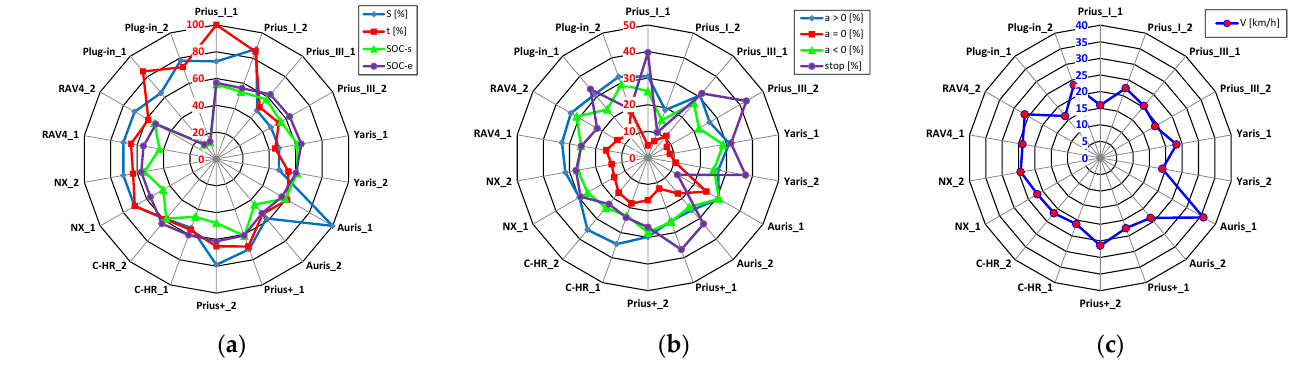
Figure 5. Analysis of vehicle traffic conditions: ( a ) percentage of time and distance traveled, as well as initial and final battery state of charge; ( b ) share of acceleration, constant speed, braking, stopping; ( c ) average speed (S — normalized distance; t — normalized time; SOC-s — SOC at the start test; SOC-e — SOC at the end test; a — acceleration; stop — normalized stop time of the car; V — vehicle speed).